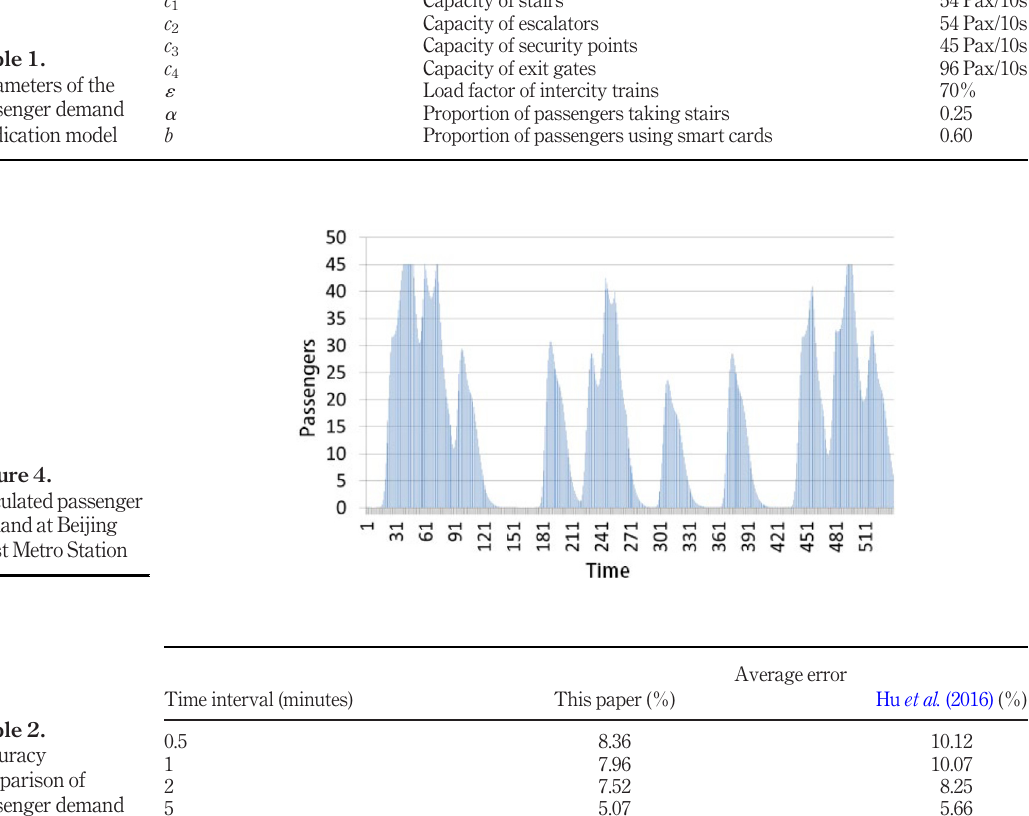
Table 1. Parameters of the